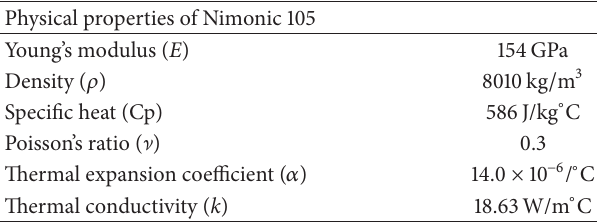
Table 1: Mechanical properties of the